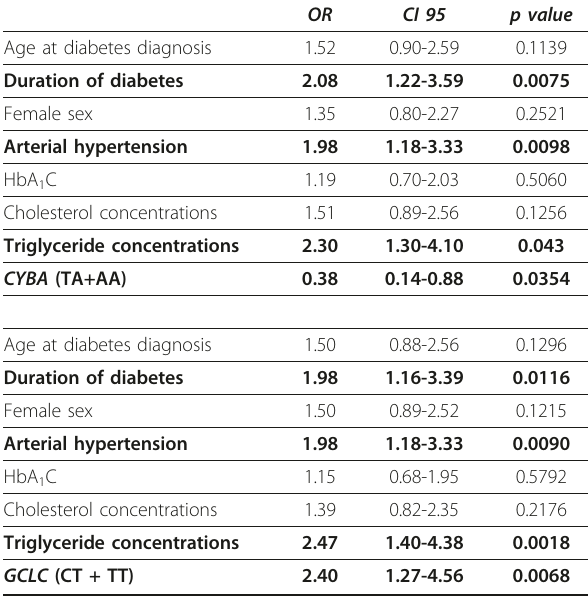
Table 4 Logistic regression analyses with glomerular filtration rate < 60 mL/min/1.73 m 2 as dependent